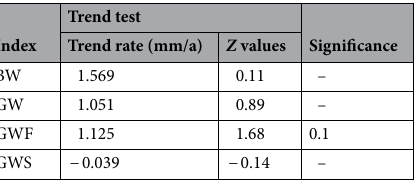
Table 2. Trend analysis of annual BW and GW resources using the M–K test in the SRB.